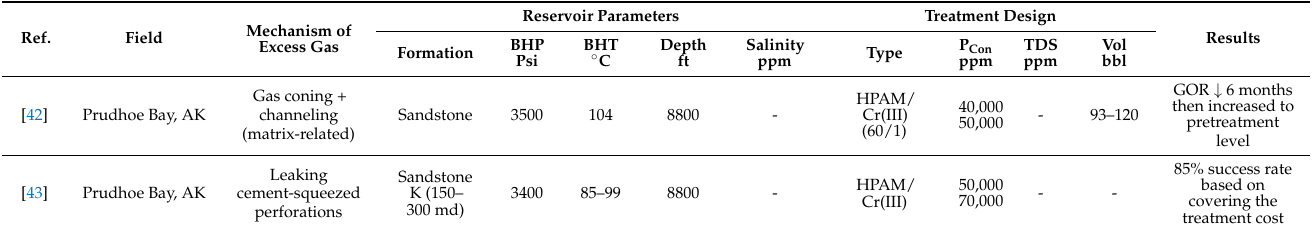
Table 3. HPAM/Cr(III)—gas shutoff treatments in oil production wells (GSOOs).